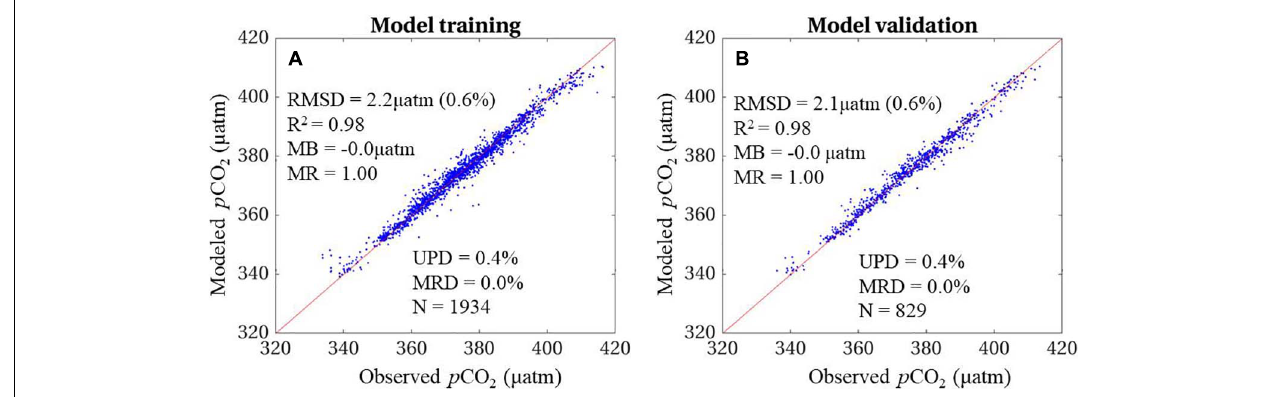
FIGURE 3 | The RFRE model performance in estimating surface p CO 2 sw in both model training (A) and model validation (B) .